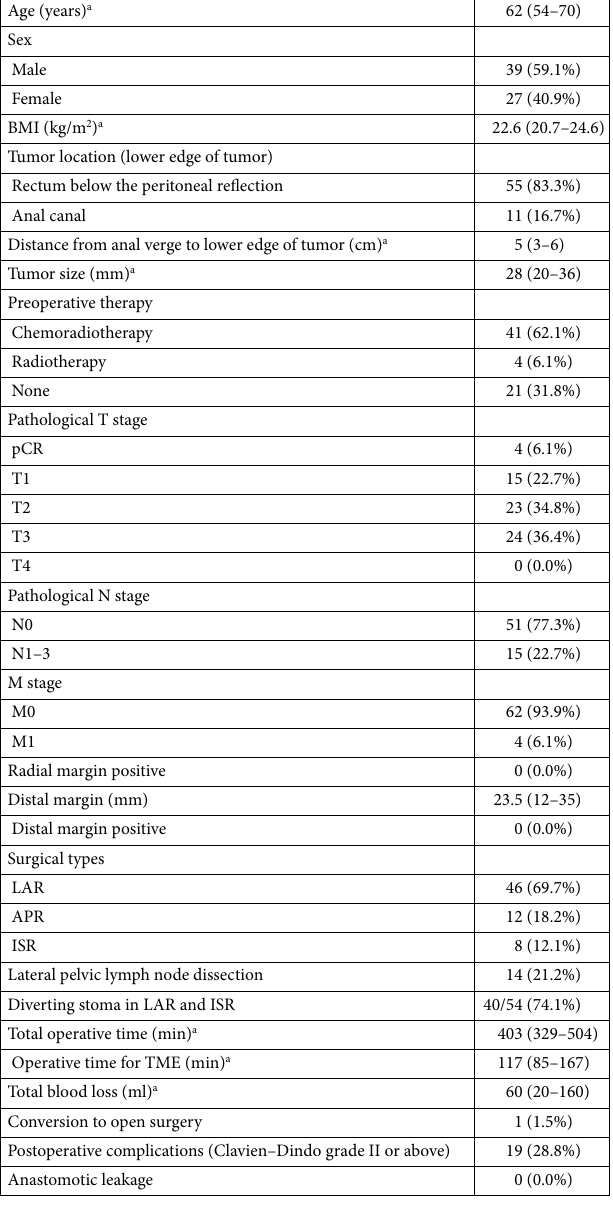
Table 1. Clinical, surgical, and pathological features of all patients ( n = 66). BMI body mass index, pCR pathologic complete response, LAR low anterior resection, APR abdominoperineal resection,